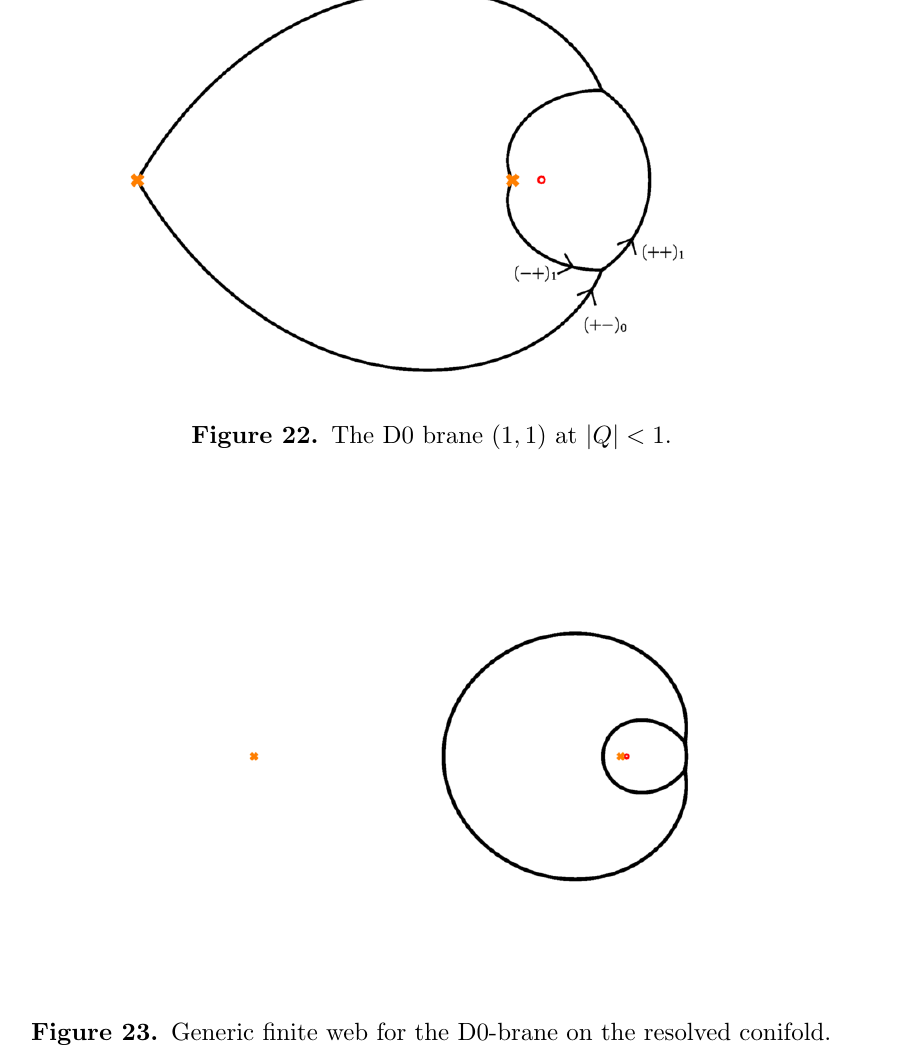
Figure 23. Generic (cid:12)nite web for the D0-brane on the resolved